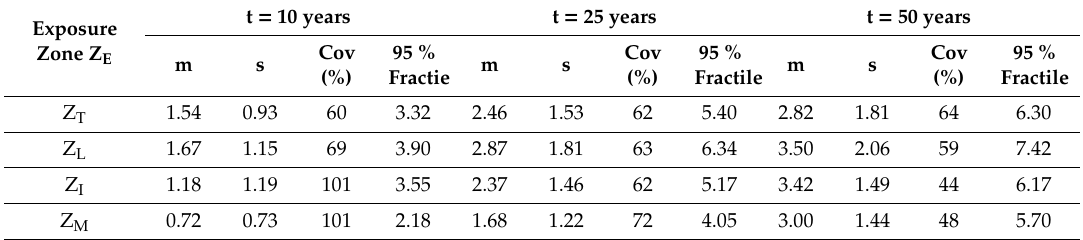
Table 3. Main statistics (m: mean; s: standard deviation) of the steel thickness loss obtained from the corrosion model for each zone after 10, 25, and 50